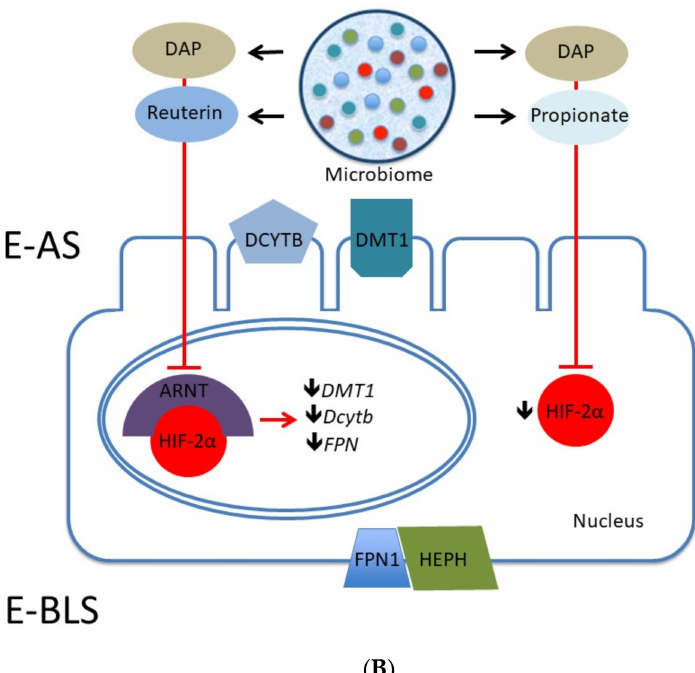
Figure 2. ( A ) Simplified model of iron transport via trans-cellular pathway in enterocytes. Dietary iron is absorbed on the apical side of enterocytes [E-AS] in form of ferritin, heme, or as Fe 2+ . A molecular background behind the uptake of ferritin by enterocytes is not yet clearly understood. Internalized ferritin undergoes degradation in lysosomes and Fe 2+ is released. Endocytosis of heme is mediated by HCP1 (haem carrier protein 1). Heme is degraded in endosomes resulting in release of Fe 2+ . Nutritional iron has to be first reduced from Fe 3+ to Fe 2+ by ferrireductase DCYTB (duodenal cytochrome b) and it is uptaken as divalent cation by the enterocytes via DMT1 (divalent metal transporter 1), which operate in mode of Fe 2+ :H+ symporter. Recycling of H + is maintained by NHE (Na + /H + xchanger). SCFA (short chain fatty acids) produced by microbiota support the acidification on luminal side of the membrane. Fe 2+ is exported from enterocytes on the basolateral side (E-BLS) by FPN1 (ferroportin 1). Released Fe2+ is oxidized by a transmembrane copper- dependent ferroxidase HEPH [hephaestin] to Fe3+, which is utilized by transferrin in circulation. Figure 2A was modified from Gulec et al. [85]. ( B ) Involvement of microbial metabolite signaling in systemic Fe homeostasis. Microbial metabolites DAP (1,3-diaminopropane) and reuterin (3- hydroxypropionaldehyde) inhibit ARNT (aryl hydro-carbon receptor nuclear translocator)–HIF-2 α (transcription factor) heterodimerization/translocation. This inhibition results in downregulation of expression of DMT1, DcytB and FPN genes, which encode for the key components of Fe homeostasis and Fe 2+ transport in enterocytes. Moreover, microbial metabolites DAP and propionate inhibit HIF-2 α expression, thus influencing expression of Fe homeostatic